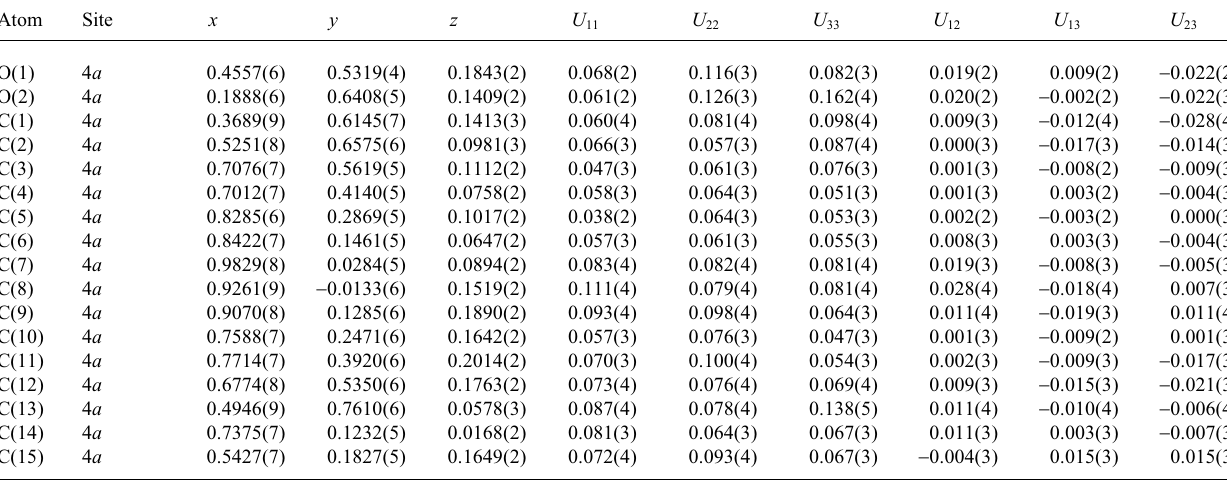
Table 3. Atomic coordinates and displacement parameters (in Å 2 )